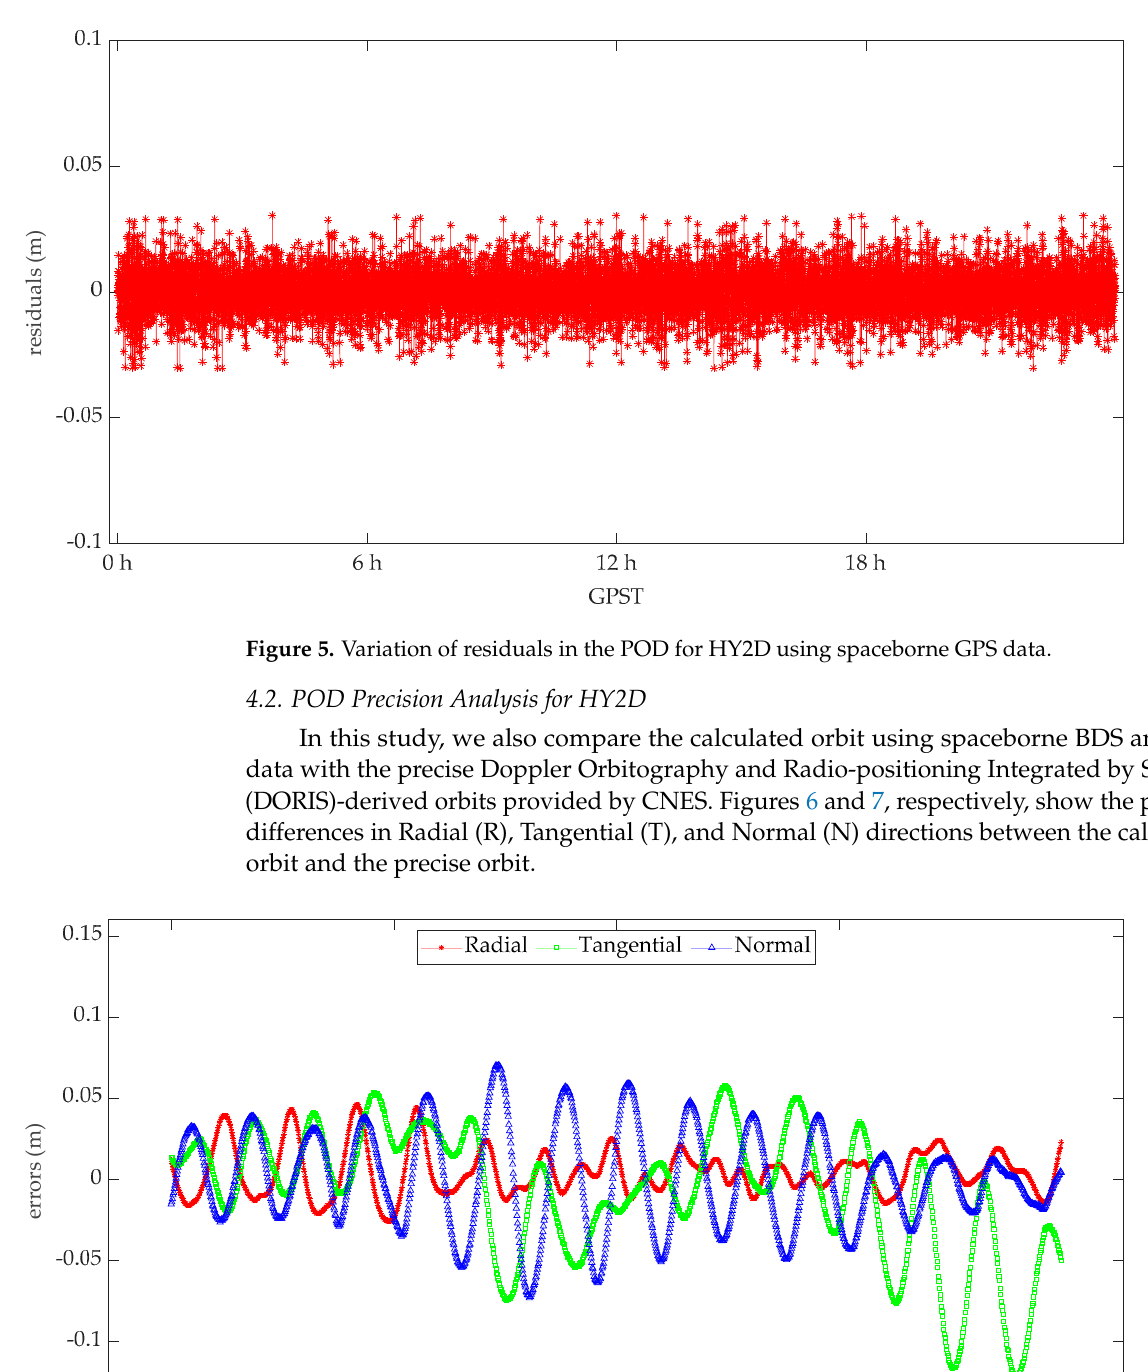
Figure 7. The variation in errors for the HY2D satellite using spaceborne GPS data compared with CNES orbit.